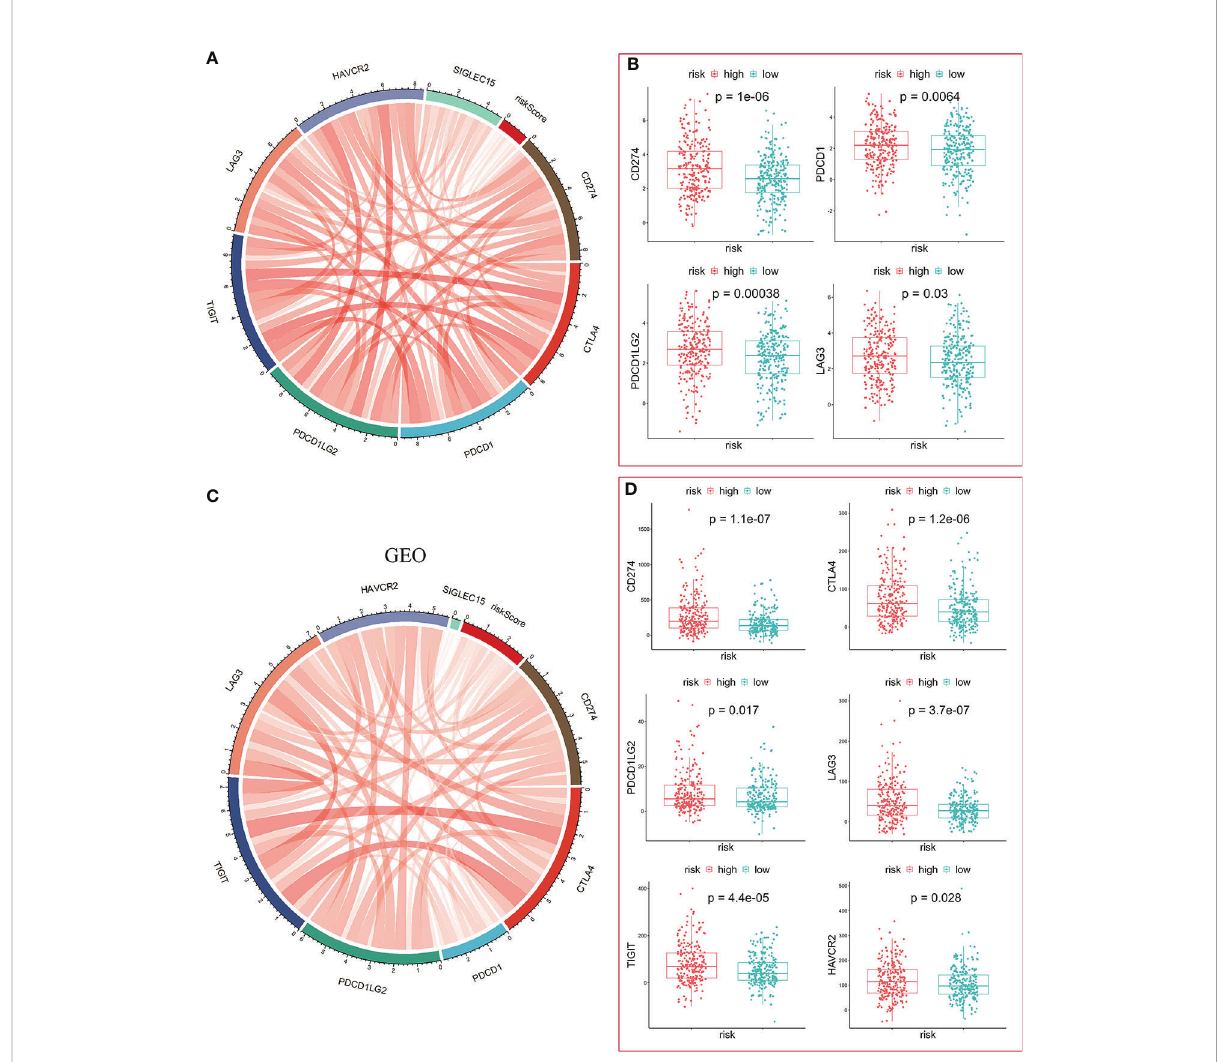
FIGURE 8 Signi fi cance of the risk model in immunotherapy. (A, C) The risk score was positively correlated with expression of immune checkpoint molecules in TCGA-LUAD (A) and GEO-GPL570-LUAD (C) , respectively. (B) The mRNA levels of CD274, PDCD1, PDCD1LG2, and LAG3 were higher in the high-risk group. (D) The mRNA levels of CD274, CTLA4, PDCP1LG2, LAG3, TIGIT, and HAVCR2 were higher in the high-risk